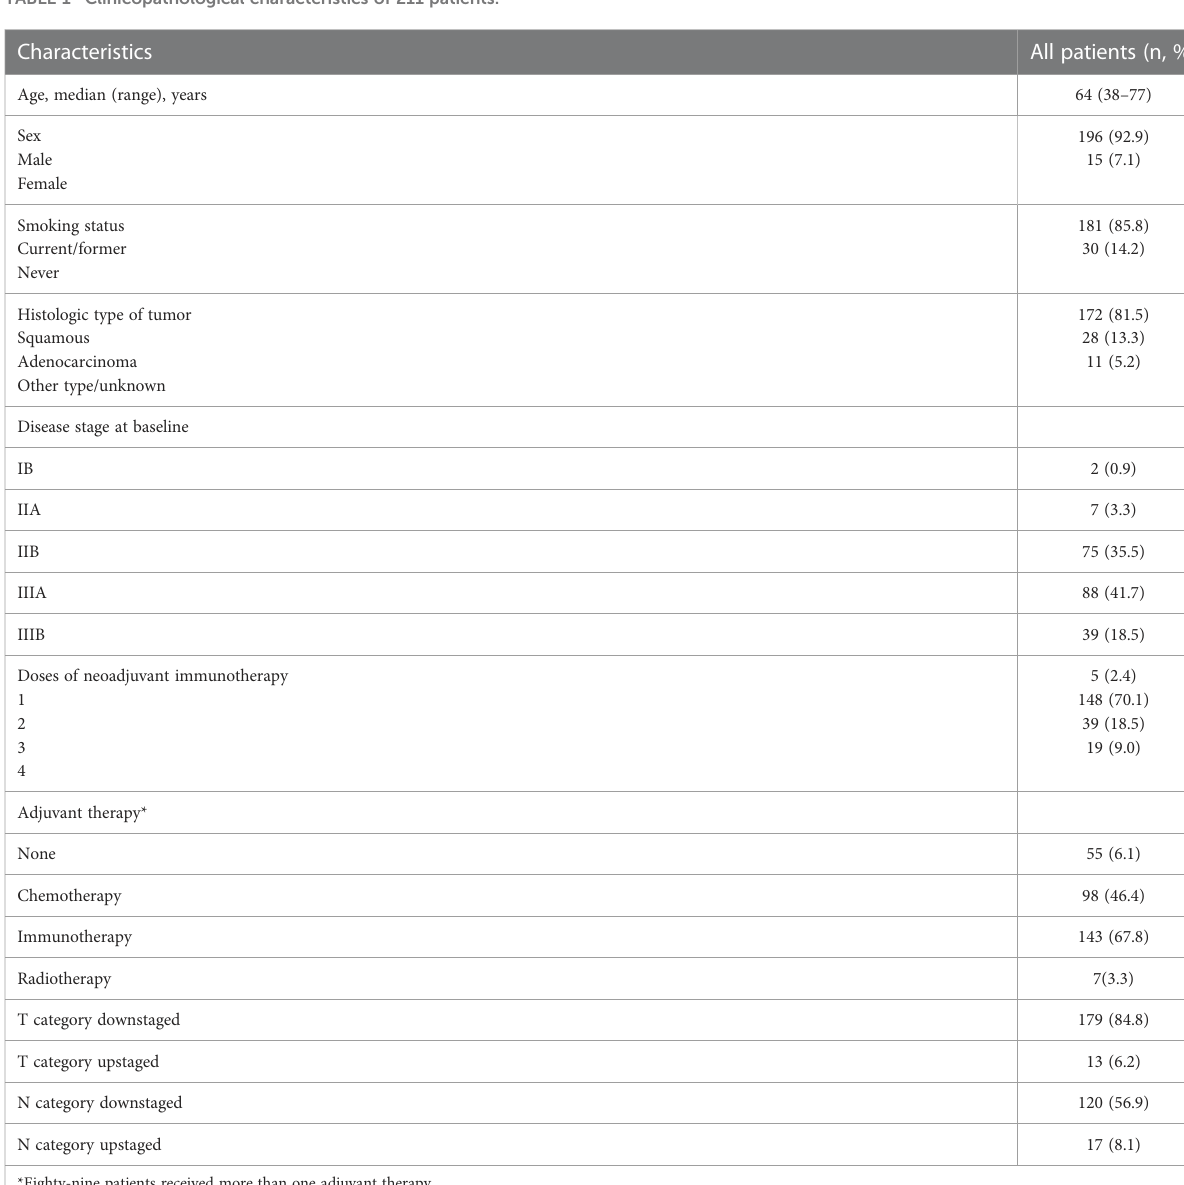
TABLE 1 Clinicopathological characteristics of 211 patients.